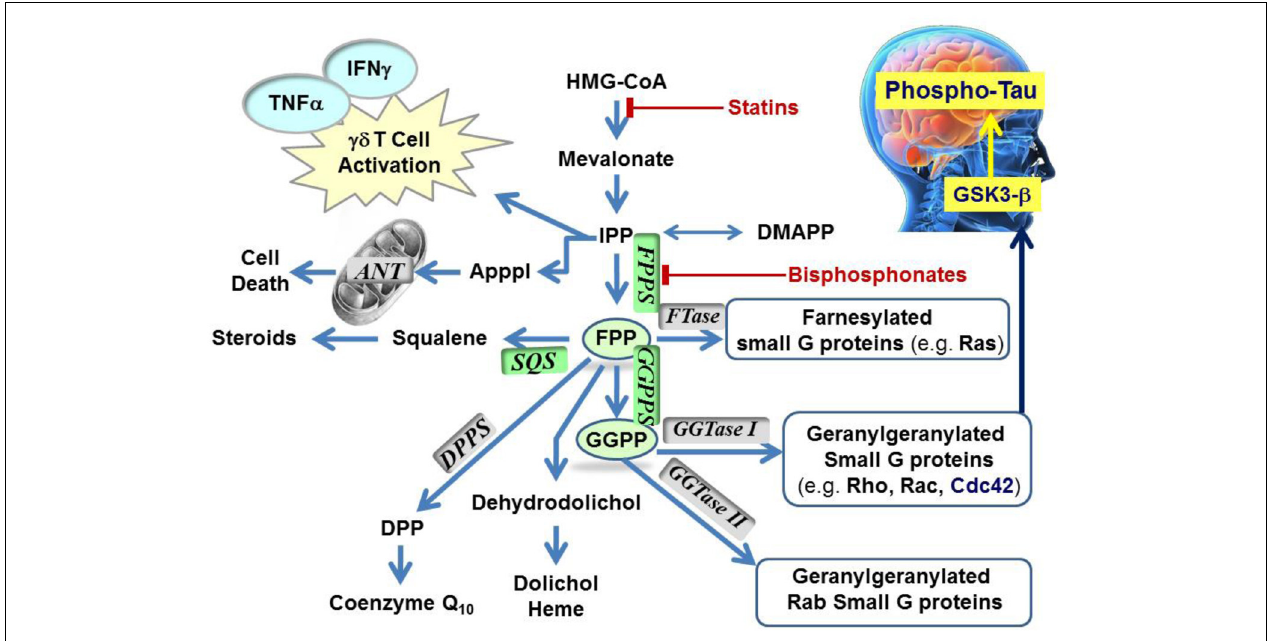
FIGURE 1 | Schematic representation of the mevalonate pathway, indicating the major biochemical effects of isoprenoids. Classes of current drugs that modulate the function of key enzymes include Statins and